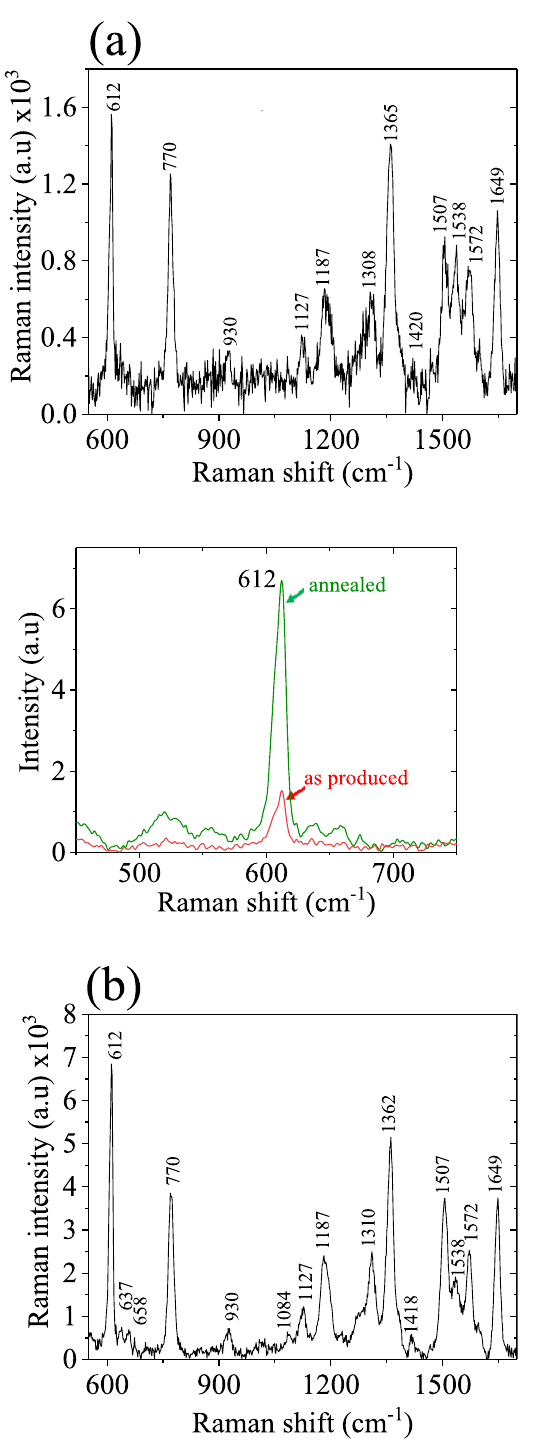
Figure 9. SERS spectra of Rh6G (10 −5 M), taken by using a laser excitation wavelength of 532 nm, power ⁓ 10 µW, and integration time of 3 s on glass surfaces covered with plasmonic metal aerosols of silver, deposited by the plasma jets of; ( a ) helium, and ( b ) argon. The inset shows a zoom portion of the SERS spectra of the characteristic peak of 612 cm −1 for quantification of the SERS